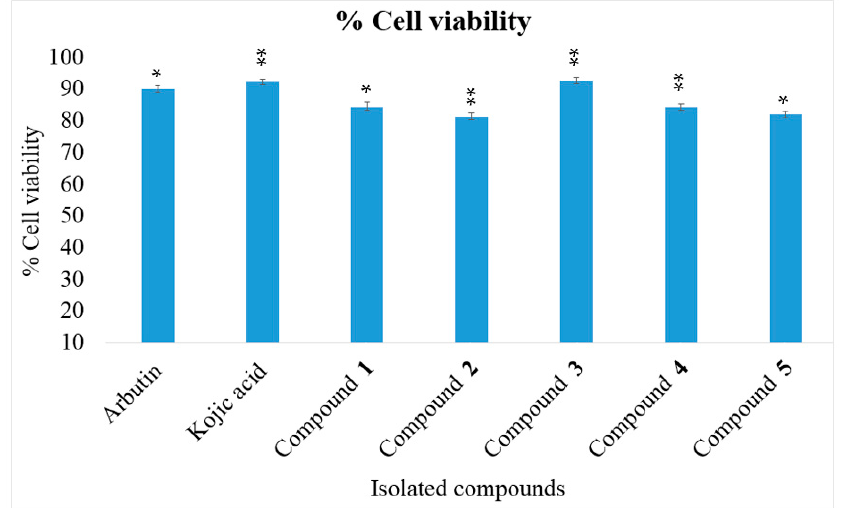
Figure 3. Cell viability of the isolated compounds at a concentration as 50 µg/mL. Data were ex- pressed as mean ± SD from three independent experiments. * p < 0.05 and ** p < 0.01 indicated a significant difference from the control group. Compound 1 = ω -hydroxymoracin C; Compound 2 = moracin M; Compound 3 = moracin C; Compound 4 = 3, 4, 3 ′ , 5 ′ -tetrahydroxybibenzyl; Compound 5 = piceatannol; positive controls = arbutin and kojic acid.